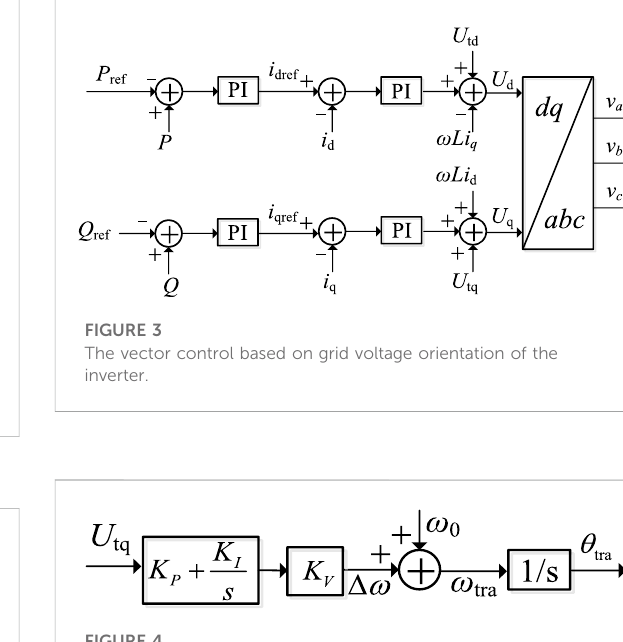
FIGURE 4 The PLL control strategy.